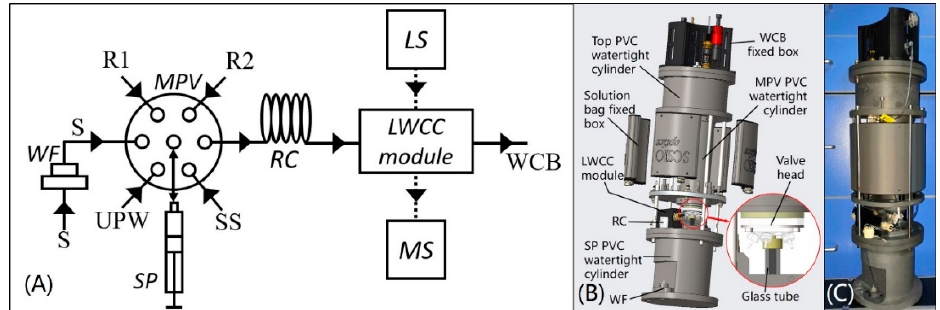
Figure 1. ( A ) System fluidic diagram of the analyzer, where LS = miniature halogen light source, MS = microspectrometer, MPV = multiposition valve, SP = high precision syringe pump, WF = water sample filtration module, RC = reaction coil, S = water sample, UPW = ultrapure water, SS = standard solution, R1 = mixed solution of ammonium molybdate, sulfuric acid and antimony potassium tartrate, R2 = ascorbic acid solution, WCB = waste collection bag; ( B ) three-dimensional model of the analyzer; ( C ) photo of the analyzer.